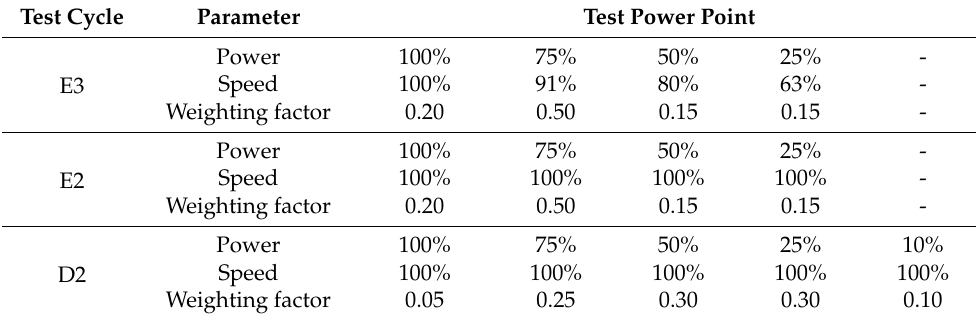
Table 1. Test cycle and weighting factors. Test Cycle